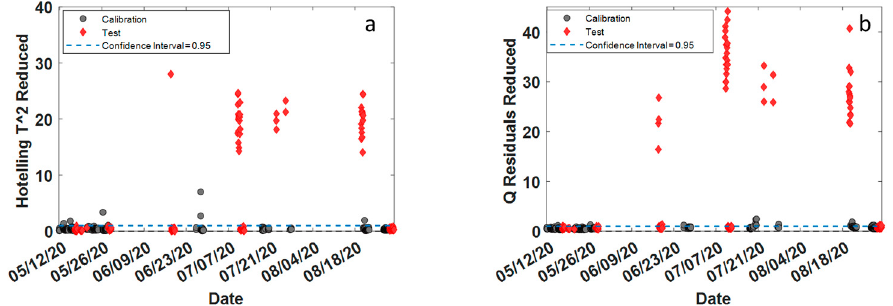
Figure 4. T 2 -( a ) and Q-( b ) based MSPC charts.